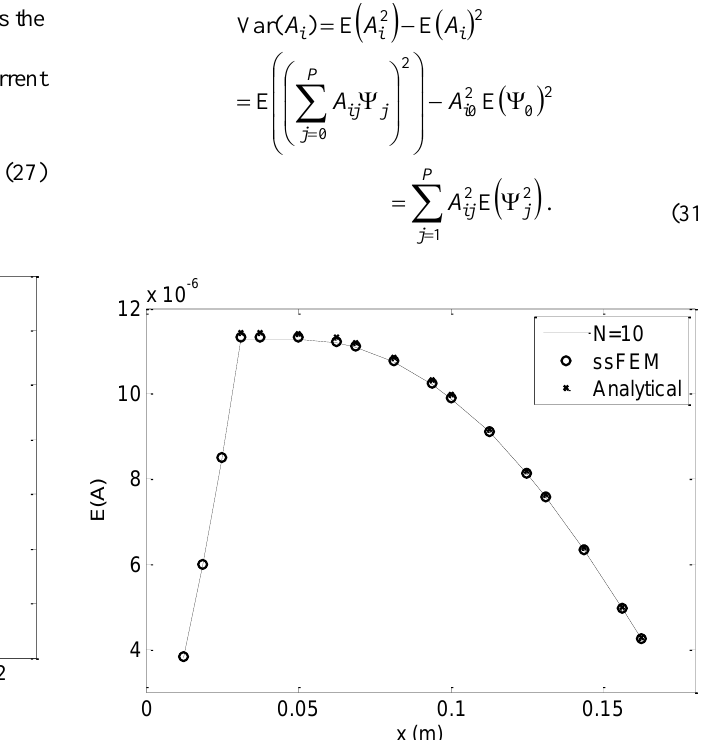
Fig. 2. The mean value of the vector potential at (x, 0.05) obtained with the Monte-Carlo method, the proposed ssFEM method and the analytical